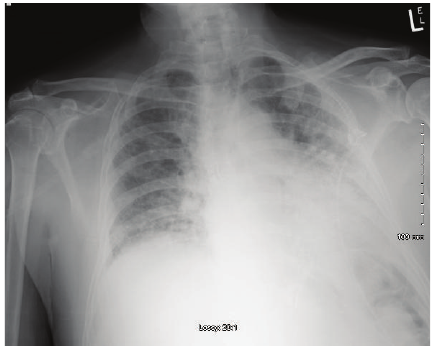
Figure 2: Chest X-ray showing worsening reticular and hazy markings throughout bilateral lung fields compared to the previous chest